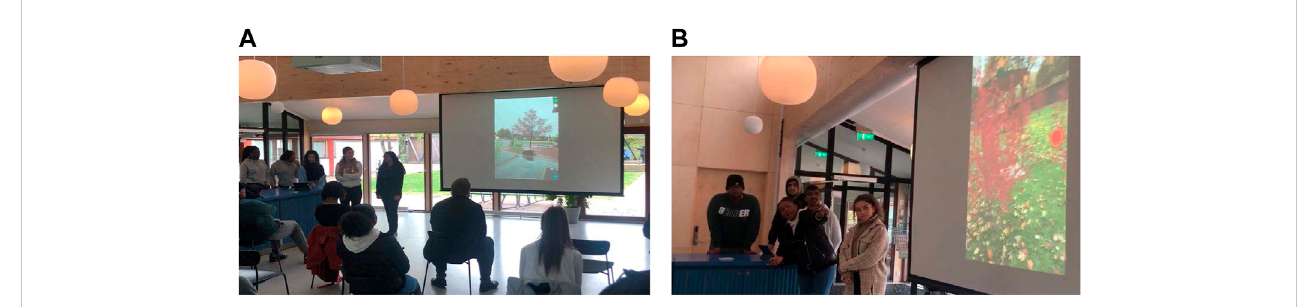
FIGURE 13 Panels (A, B) : At the end of the workshops, Youth presented their designs to politicians and experts.